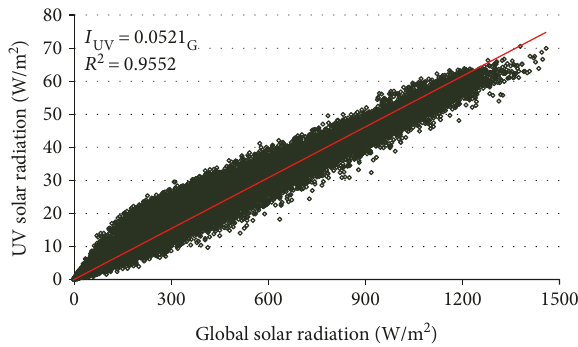
Figure 7: Correlation between the UV radiation in function of global radiation for the city of Recife.